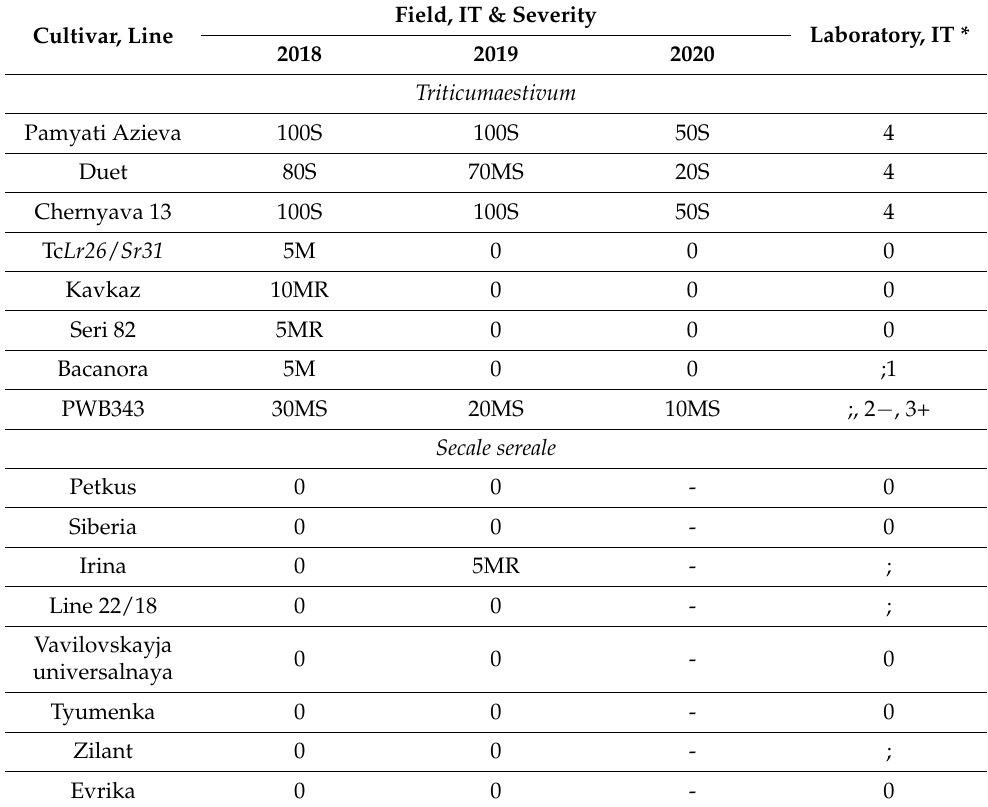
Table 1. Results of estimation of stem rust development on cultivars and lines of T. aestivum. and S. cereale in the field (Western Siberia, Omsk) and in the